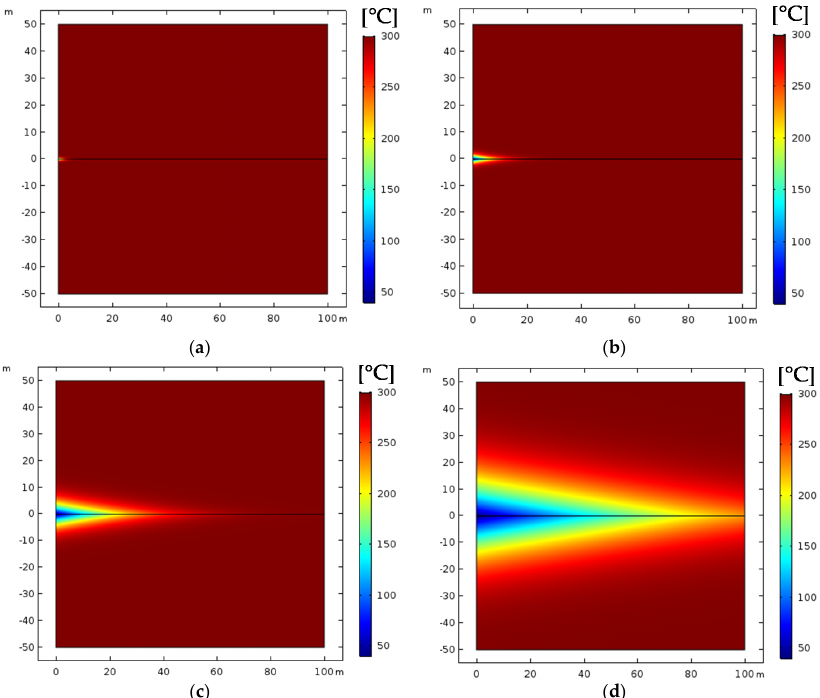
Figure 7. Temperature change over time in the range of: ( a ) t = 1 day; ( b ) t = 10 days; ( c ) t = 100 days; ( d ) t = 1000 days.